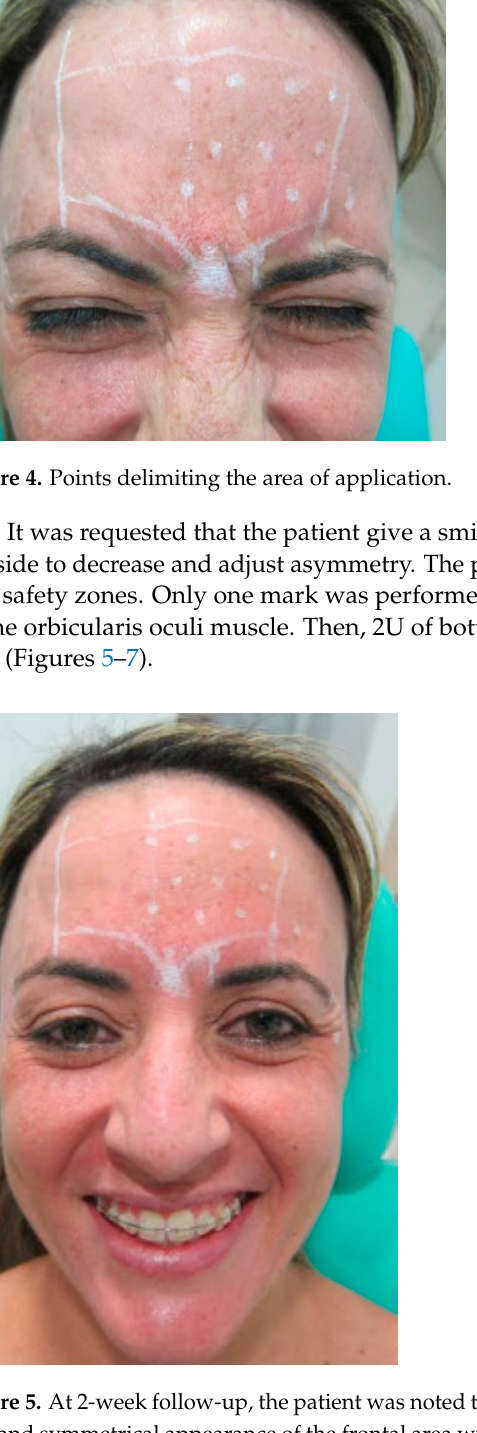
Figure 6. After 14 days, contraction of the procerus and corrugator muscles shows an equilibrium.